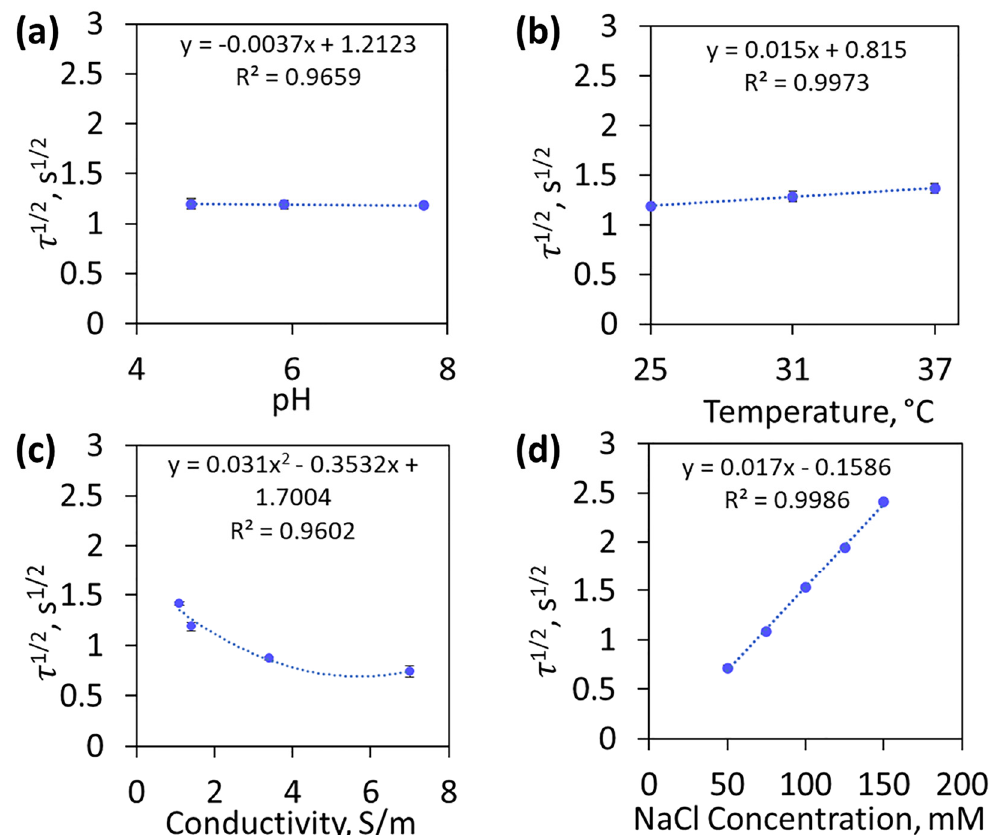
Figure 9. The effect of ( a ) pH at 20 mM Na 2 SO 4 and 100 mM NaCl at 25°C; ( b ) temperature in 20 mM Na 2 SO 4 and 100 mM NaCl; and ( c ) conductivity with varying Na 2 SO 4 concentrations and 100 mM NaCl at 25 °C with respect to average squared root of transition time (N = 3) in 480 A/m 2 . The effect of other ions was investigated with ( d ) NaCl-spiked artificial urine as a function of the average square root of transition time (N = 3) at 480 A/m 2 and 25 °C. Each curve was fit with a regression line (blue dotted line).